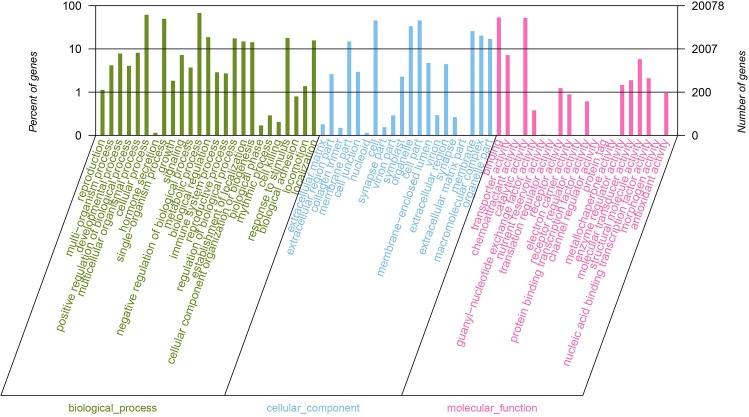
Gene Ontology classification of assembled unigenes.The unigenes were categorized into three main categories: biological process, cellular component, and molecular function.